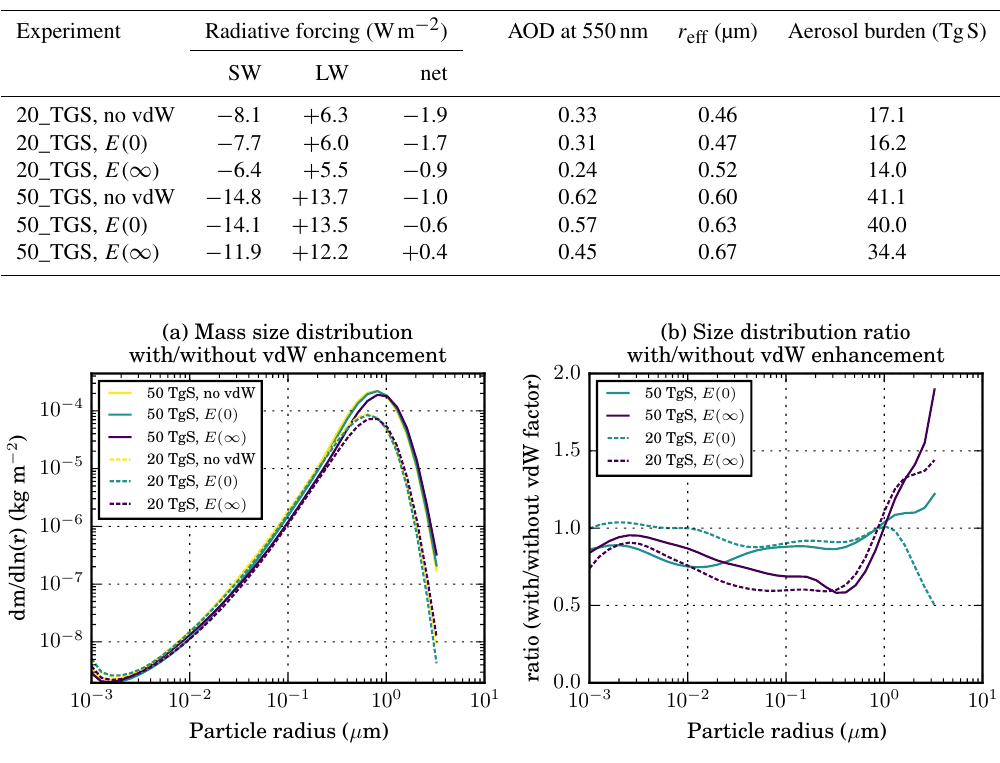
Figure 13. (a) Column-integrated global and annual mean stratospheric aerosol mass size distribution (d m/ dln r , in kgm − 2 ) for the exper- iments with and without van der Waals (vdW) enhancement of coagulation with the continuum regime enhancement factor E( 0 ) and the kinetic regime enhancement factor E( ∞ ) , respectively. (b) Ratio between the size distributions in the experiments with and without the vdW enhancement